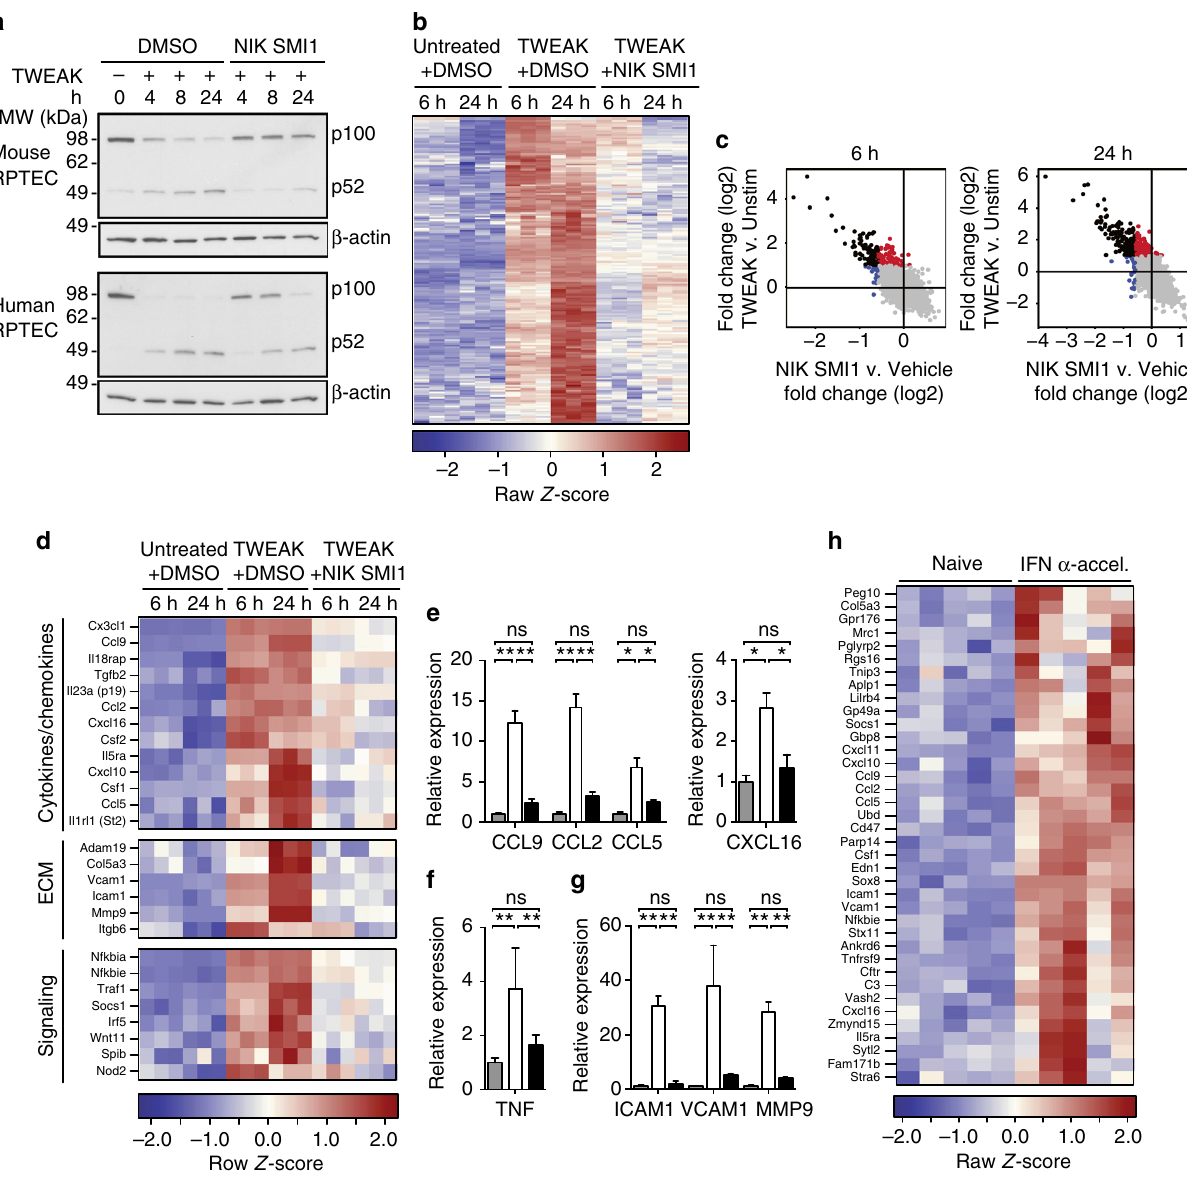
Fig. 4 NIK is required for TWEAK-induced gene regulation. a Western blot analysis of p52 processing in mouse and human renal proximal tubulo- interstitial cells (RPTEC) stimulated with TWEAK in the presence or absence of NIK SMI1 (human 1 μ M, mouse 3 μ M) at 4, 8, and 24 h. b – d Differential gene expression (RNASeq) in murine RPTEC stimulated with TWEAK (100 ng/mL) in the presence or absence of 3 μ M NIK SMI1 for 6 or 24 h. b Heat map of TWEAK inducible genes (FC > 2, p < 0.05) inhibited by NIK SMI1 (FC < − 1.5, p < 0.05) ( c ) Plot of TWEAK inducible and NIK regulated genes at 6 and 24 h. TWEAK inducible — NIK regulated genes, black; TWEAK inducible — not NIK regulated, red; unaffected by TWEAK, but regulated by NIK, blue. d RNASeq heat map of TWEAK inducible — NIK-dependent genes that are speci fi cally relevant to lupus. e – g Con fi rmation by qRT-PCR of select genes identi fi ed by RNASeq. qRT-PCR data represented as mean ± standard deviation of three biological replicates run in experimental duplicate, and normalized to expression of HPRT. Unstimulated + DMSO (gray bar), TWEAK (100 ng/mL) + DMSO (white bar), and TWEAK (100 ng/mL) + 3 μ M NIK SMI1 (black bar). h Heat map, TWEAK inducible — NIK-dependent genes signi fi cantly elevated in kidneys of IFN α -accelerated NZB/W F1 mice with proteinuric disease (FC > 2, p < 0.05). Statistics: e – g one-way ANOVA with Tukey ’ s test for multiple comparisons. * p < 0.05, ** p < 0.01, *** p < 0.001; **** p < 0.0001; ns